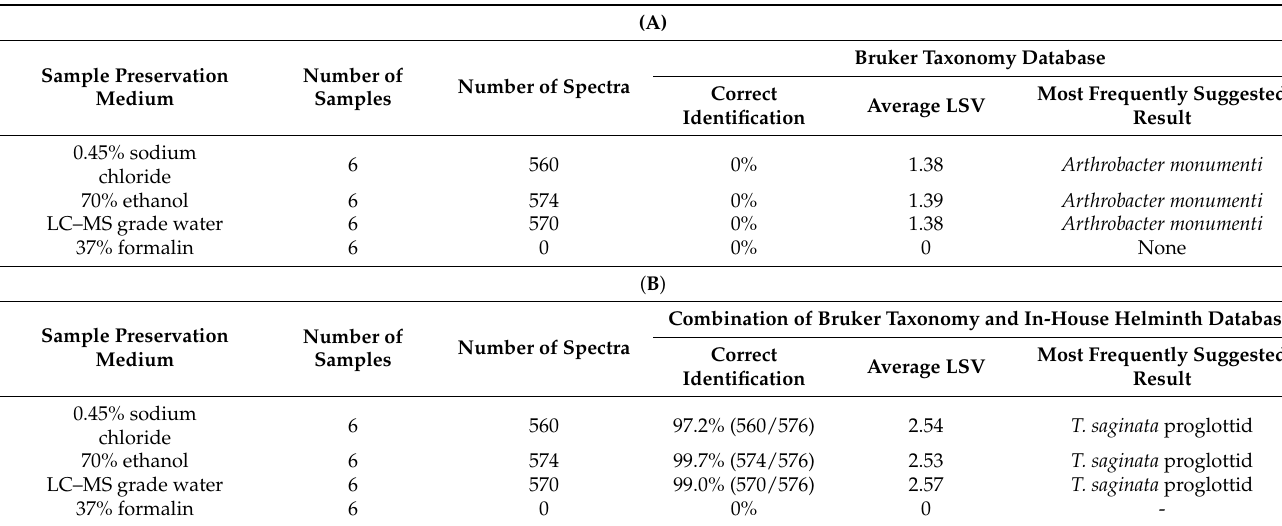
Figure 1. Protein spectral profiles of Taenia saginata proglottids. The peaks obtained when measuring the original sample, and protein profiles after prolonged storage in four different media, are displayed. X -axis, mass-to-charge ratio of ( m / z ); Y -axis, peak intensities of ionized molecules; a.u., arbitrary unit. Table 1. Identification of Taenia saginata proglottids stored in different storage media ( A ) using Bruker Taxonomy, the commercially available database for bacteria and fungi, and ( B ) using a combination of Bruker Taxonomy and an in-house helminth